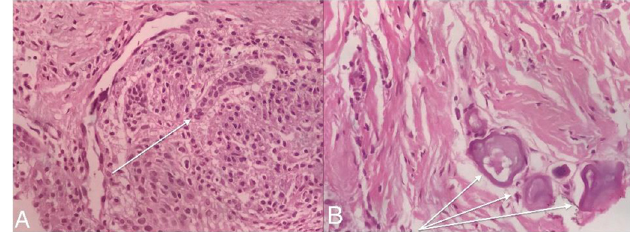
Fig. 3. Histologic sections showing: (A) The odontogenic island, pointed with arrow, (B) Pssammomatoid